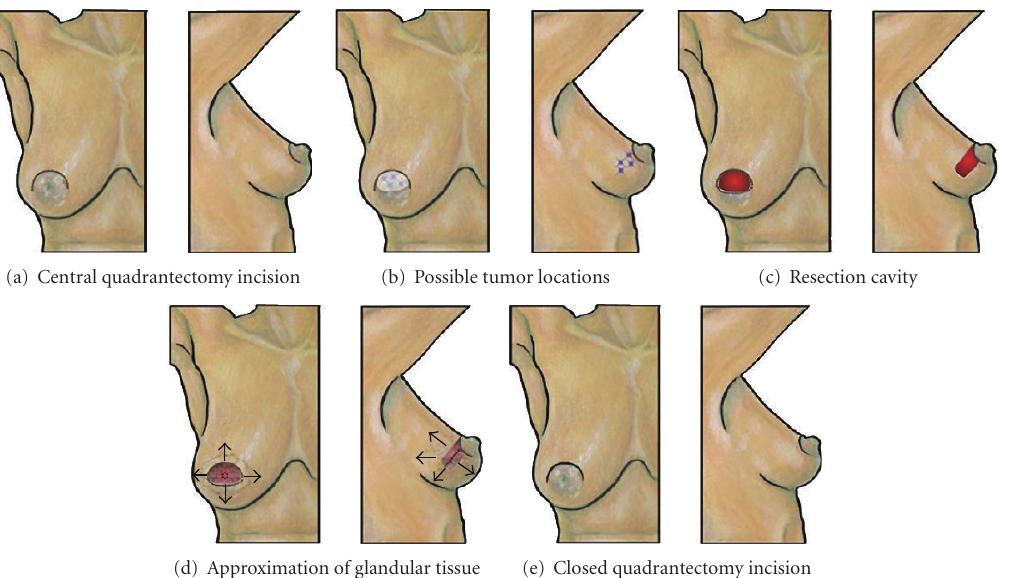
Figure 9: Central quadrantectomy. (a) Shows location of central quadrantectomy skin incision. (b) Shows multiple “stars” indicating possible tumor locations suitable for this approach. (c) Shows resection cavity following excision of malignancy. The nipple-areolar complex was omitted in the left image to allow visualization of surgical cavity. (d) Shows results of glandular flap advancements that allow the surgical margins to be sutured together using purse-string sutures to obliterate the surgical cavity. Arrows showing undermining of skin flaps in the central breast. Nipple-areolar complex omitted in the left image to allow visualization of the approximated glandular tissue. (e) Shows breast following closure of the skin